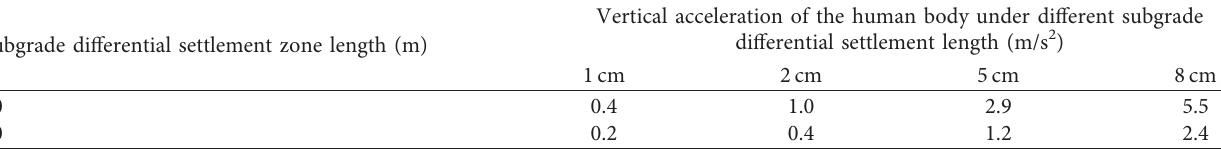
Figure 4: Subgrade curve deformation. Table 6: Vertical acceleration under different subgrade differential settlement length.